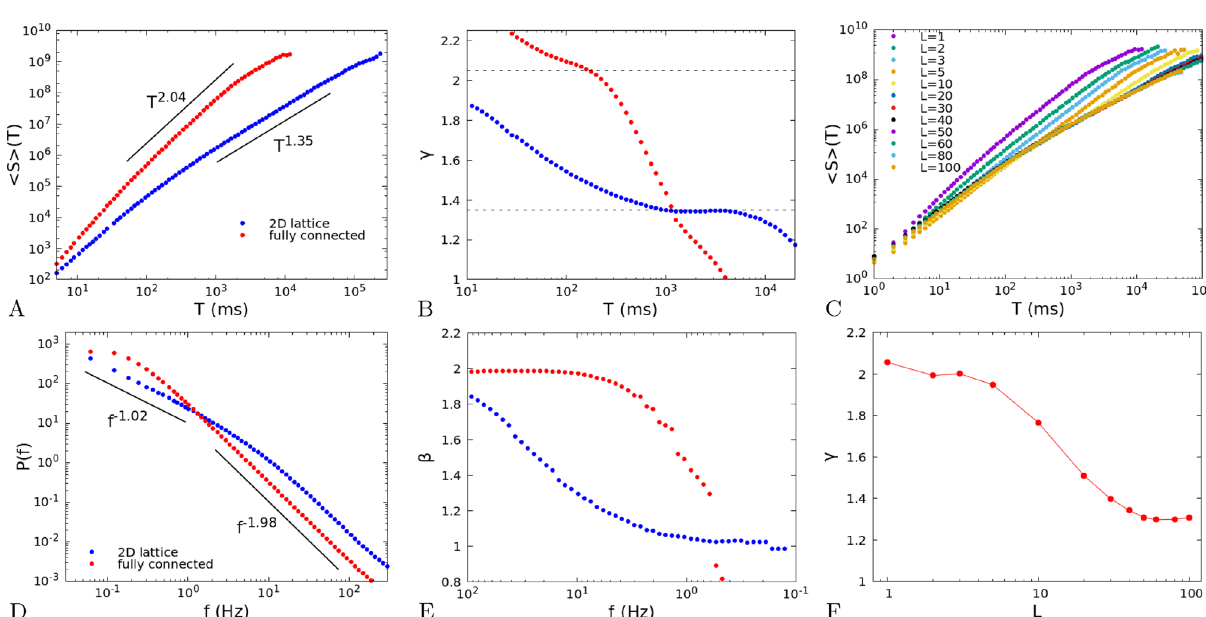
Figure 4. ( A ) Avalanche size distribution P ( S ) for a 2D system with L (cid:31) 1 (blue dots) and for a fully-connected system with L = 8 , δ 0.1 , h 10 1 ms. The number of neurons is 10 8 per site. ( B ) Avalanche duration distribution P ( T ) w 0,0 − ˜ = = = for the same system and parameters. The fits of the power-law exponents are done with the Python program “powerlaw” 25 in the ranges indicated by the black lines.